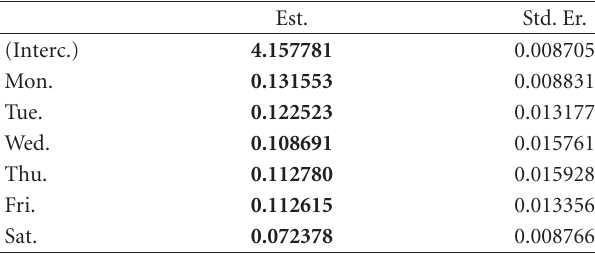
Table 3: Coe ffi cients of the parametric part of the additive model for NO 2 (bold indicates 5% significance). Est. Std.